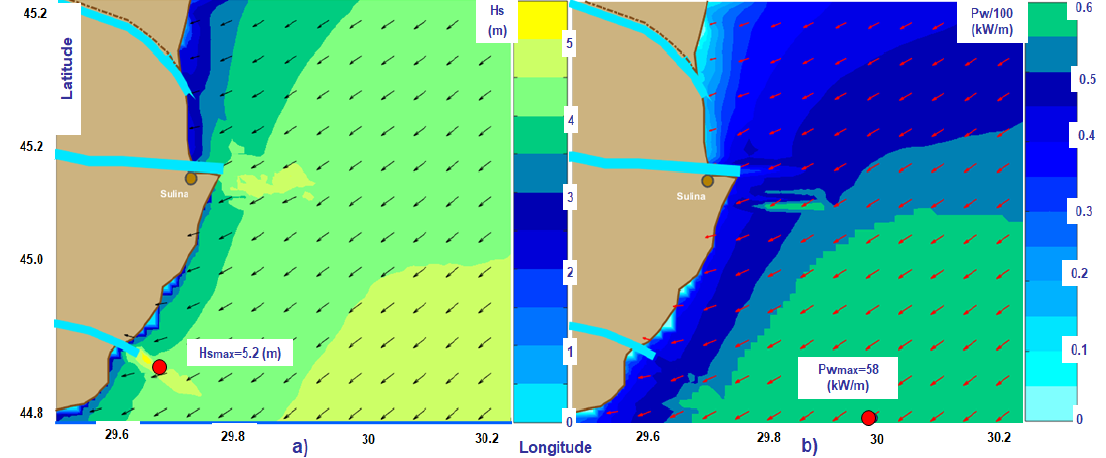
Figure 6. High wave conditions at the mouths of the Danube River (computational domain Sph3), model results corresponding to the time frame 22 March 2017. ( a ) Significant wave height scalar fields and wave vectors (represented by black arrows); ( b ) wave power scalar fields and energy transport vectors (represented by red arrows).